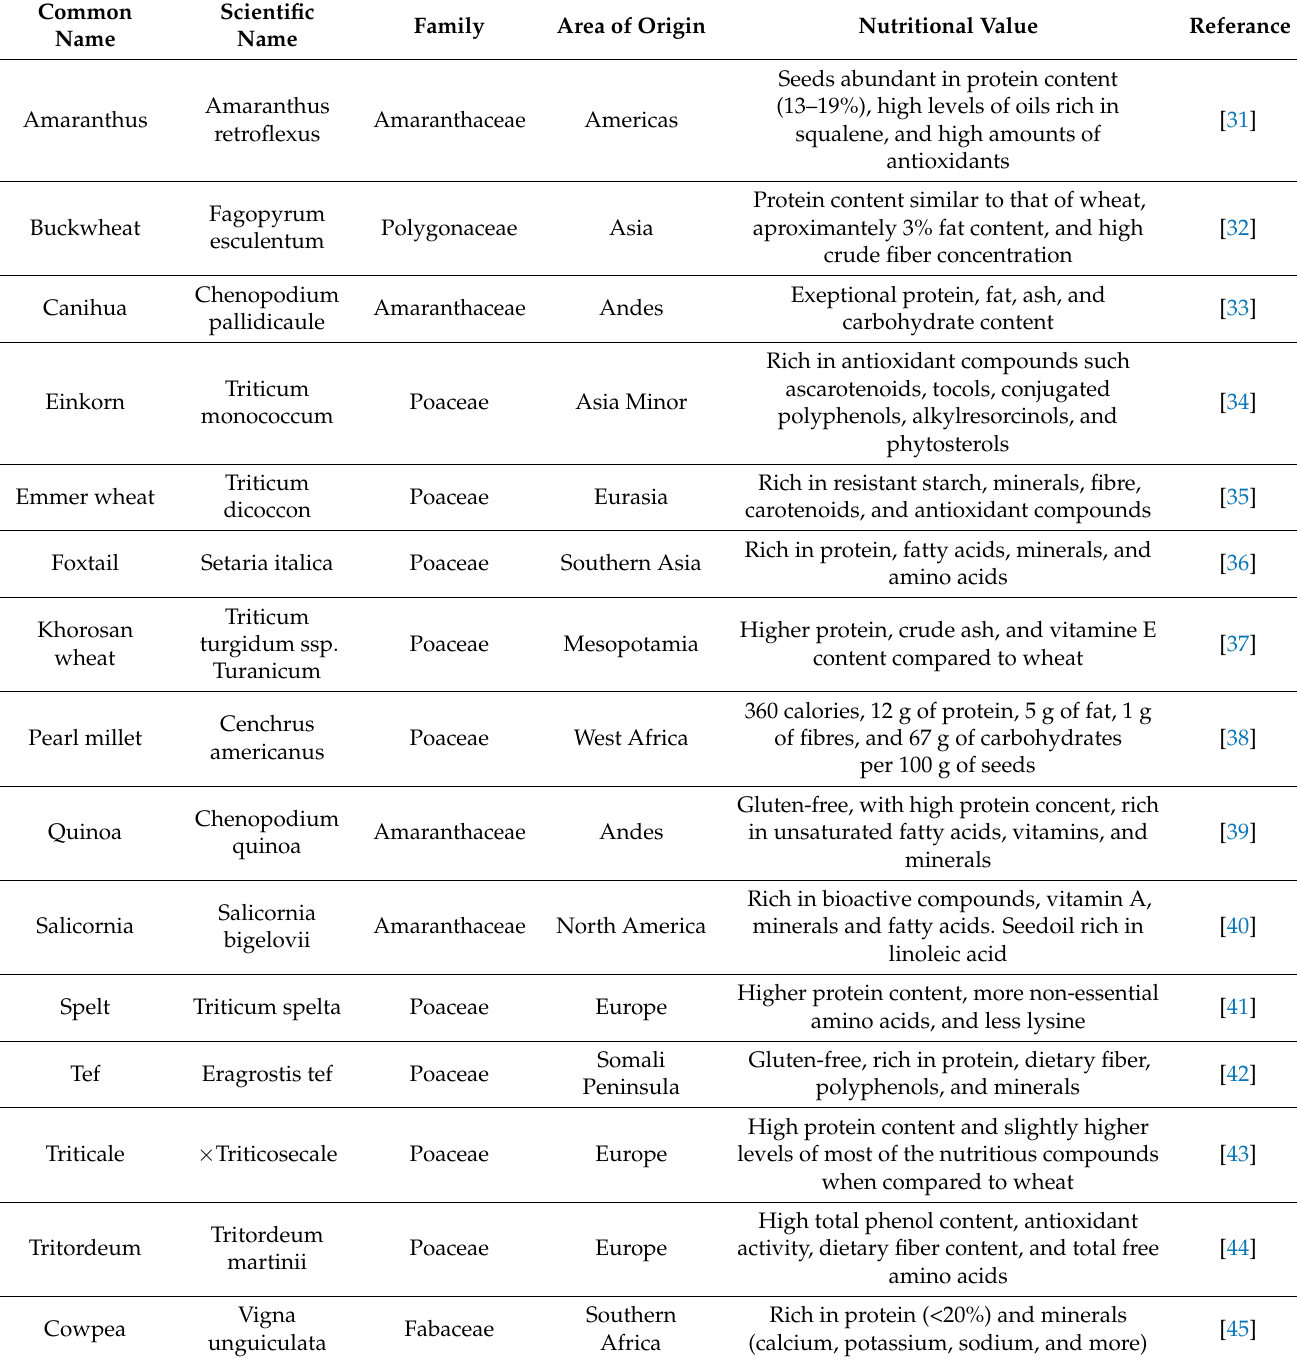
Table 1. List of crops that have been proposed as ACs [21,27], their common and scientific names, family, area of origin, and nutritional value. These crops have been proposed as ACs due to their ac- climatization potential to marginal environments and/or their tolerance to biotic (pests and diseases) or abiotic stress (high salinity and sodicity, droughts, and high